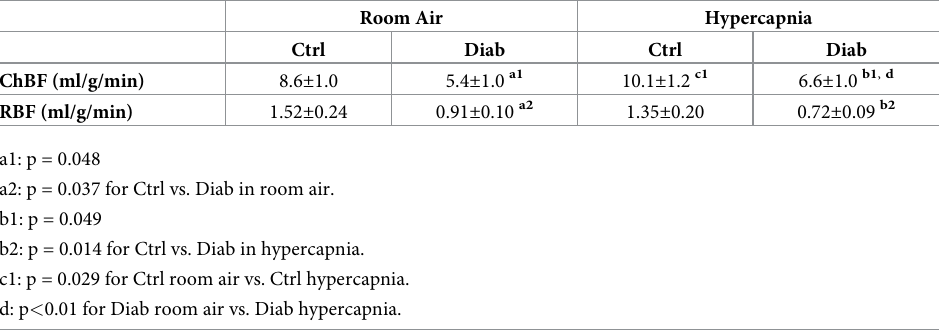
Table 3. MRI BF measures from the nasal region recorded in regular room air and in hypercapnia (mean ±